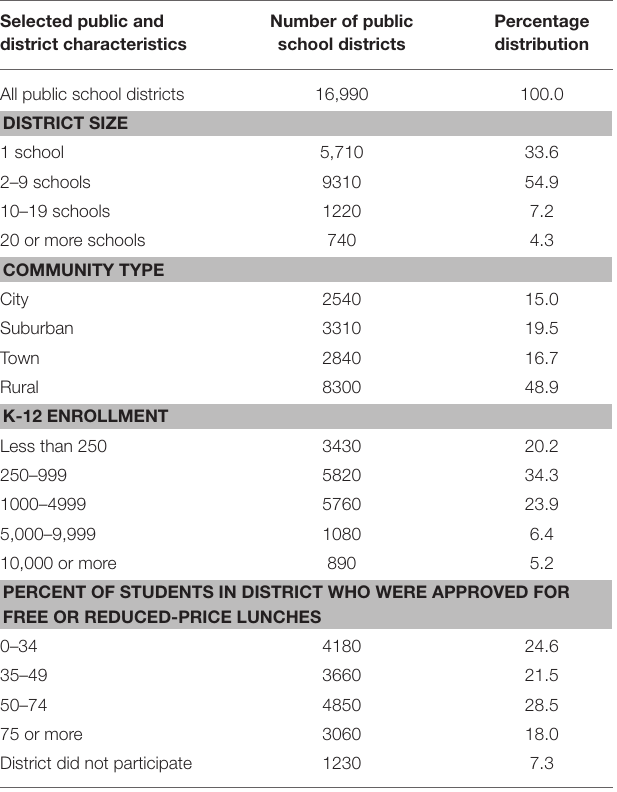
A table from the U.S. Department of Education, National Center for Education Statistics, School and Staffing Survey (SASS). Adapted from Gray et al. (2013). Numbers are